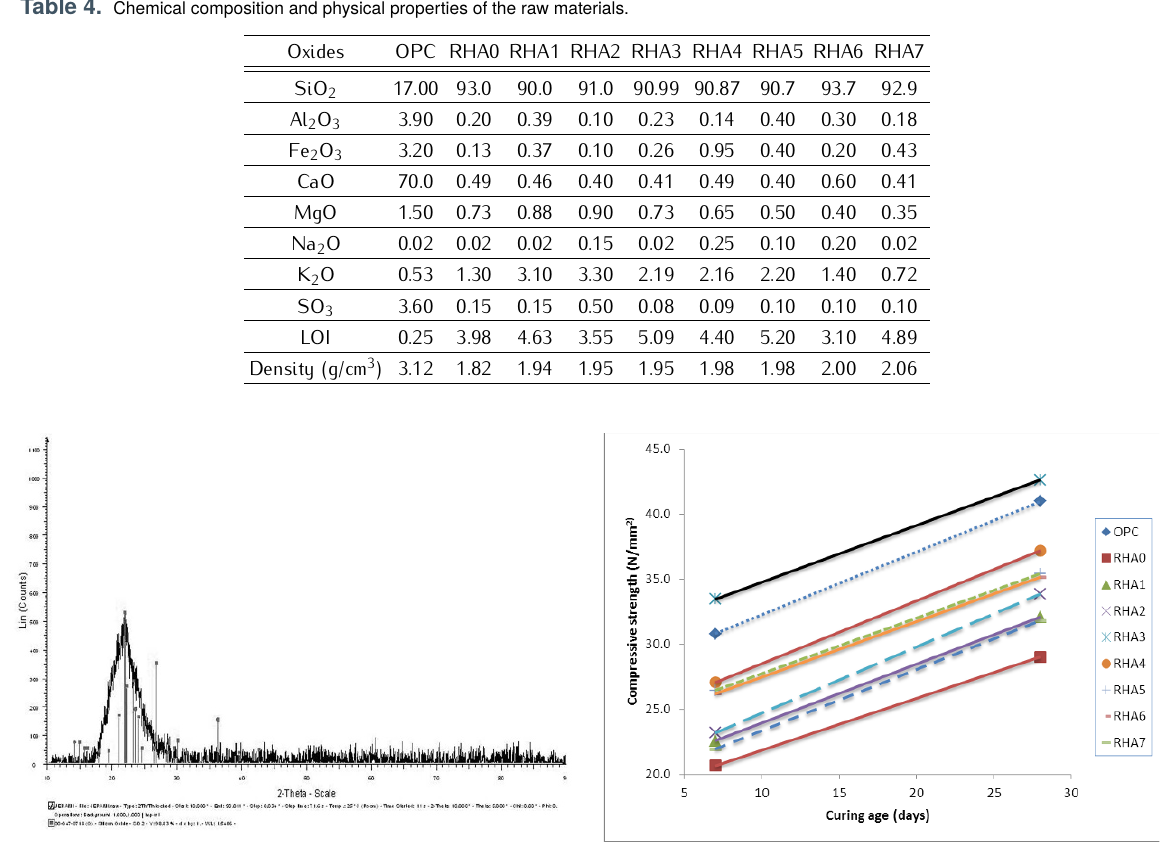
Figure 4. XRD pattern of amorphous silica of RHA.